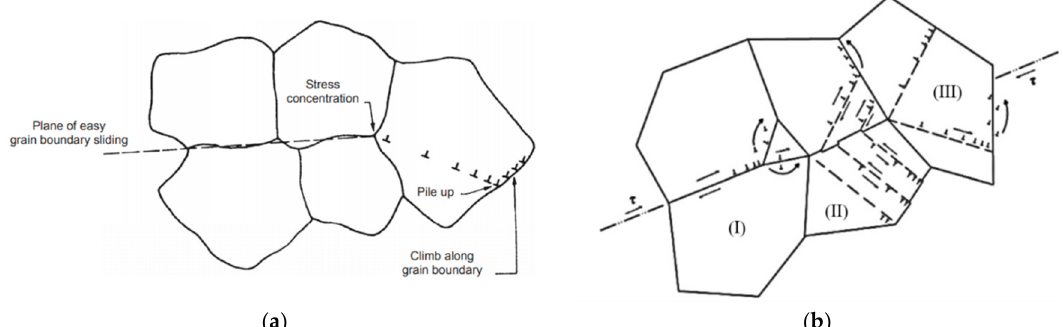
Figure 15. ( a ) Illustration of the Ball–Hutchison model of grain boundary sliding (GBS) accommodated by dislocation movement, [140]. ( b ) Slip accommodation of GBS proposed by (I) Gifkins, (II) Mukherjee, and (III) Ball and Hutchinson [76].